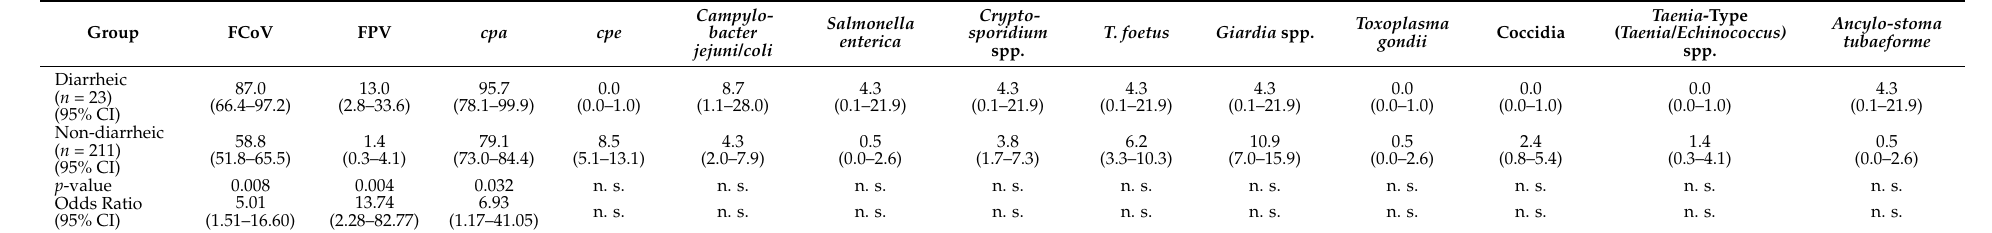
Table 4. Prevalence (%) and 95% confidence intervals (95% CI) of feline coronavirus (FCoV) and other potential enteropathogens in the 234 cats. Cats